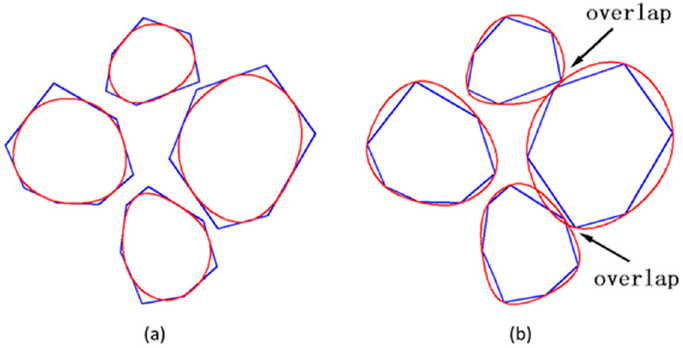
Figure 14. Illustration for the construction of gravel aggregates, ( a ) side midpoint as a spline control point, and ( b ) vertex as a spline control point. Among these, the red lines represent spline curves while the blue lines indicate aggregate boundaries.